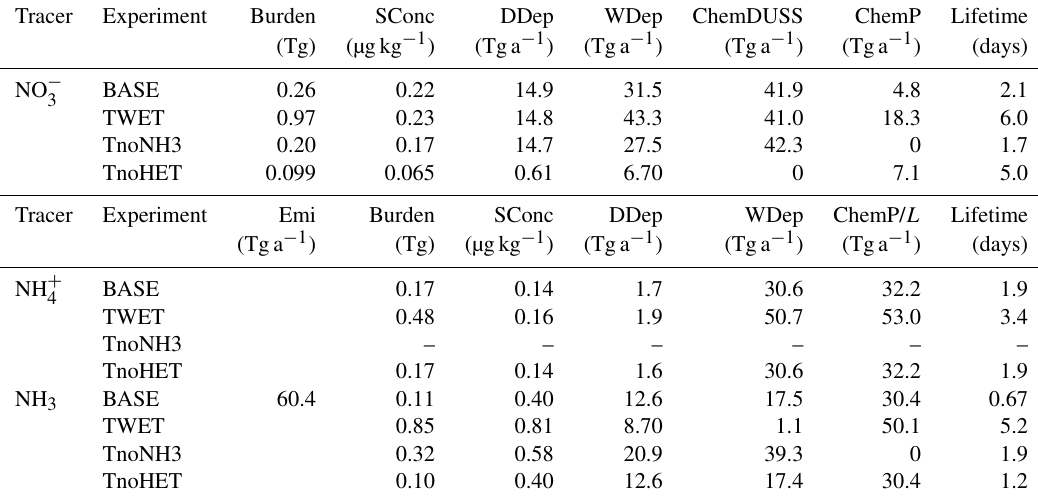
Table 7. NO − , NH + , NH 3 and HNO 3 budgets from the base simulation and three sensitivity 3 4